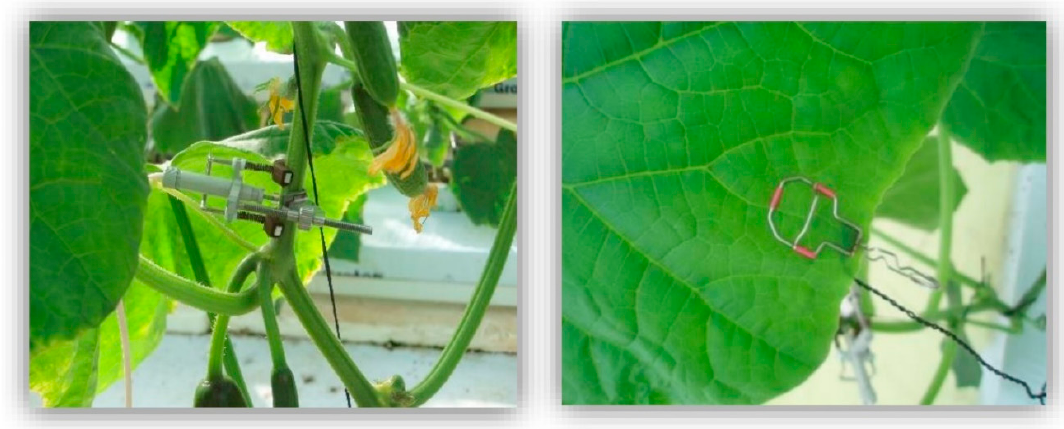
Figure 4. Stem micro-variation sensor (left) and a contact leaf temperature sensor (right).